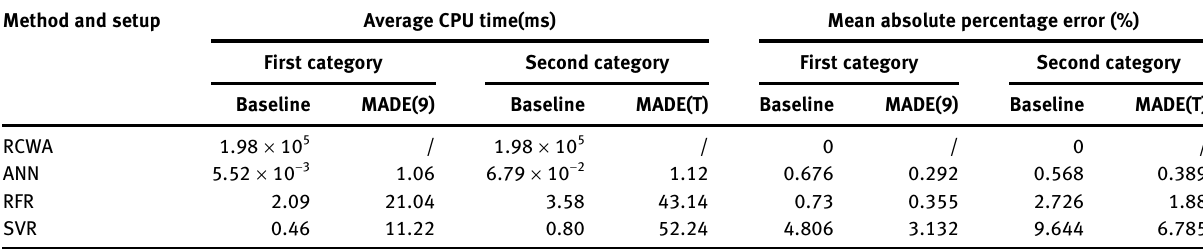
Table  : Average consumed central processing unit (CPU) time and mean absolute percentage error (MAPE) of different methods. Method and setup